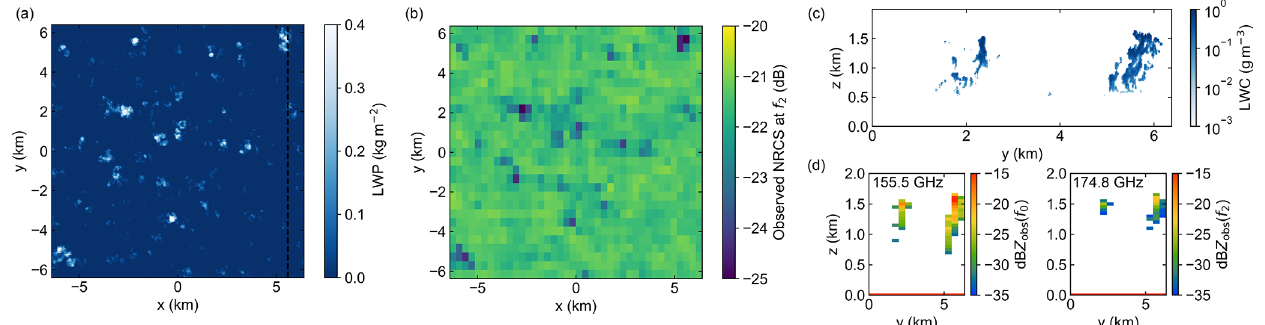
Figure 6. Selected results from BOMEX forward simulations. (a) Liquid water path (LWP) map for the shallow cumulus scene highlighting the low cloud area fraction. (b) Simulated observed ocean surface NRCS at 174.8GHz at the radar resolution. (c) Cloud LWC profiles corresponding to the dashed line in panel (a) . (d) Observed reflectivity profiles at 155.5 (left) and 174.8 (right)GHz.